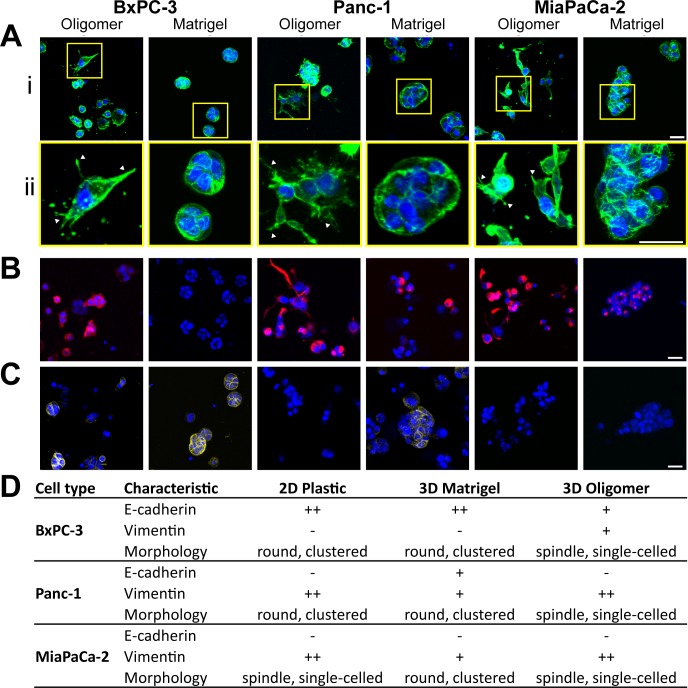
Stromal ECM drives pancreatic cancer cell morphology and phenotype.BxPC-3, Panc-1, and MiaPaCa-2 cells were cultured (2x105 cells/mL) for 4 days within Oligomer (0.9 mg/mL; 100 Pa) and Matrigel (100 Pa). Constructs were stained for actin (A; green), vimentin (B; red), E-cadherin (C; yellow), and nuclei (blue) and imaged using confocal microscopy. Images represent z-stack projections (100 μm thickness; scale bar = 30 μm). Yellow boxes represent 3X digitally zoomed sections (ii) and arrowheads note prominent actin protrusions. (D) Table summarizing protein expression and morphological observations from panels A-C.